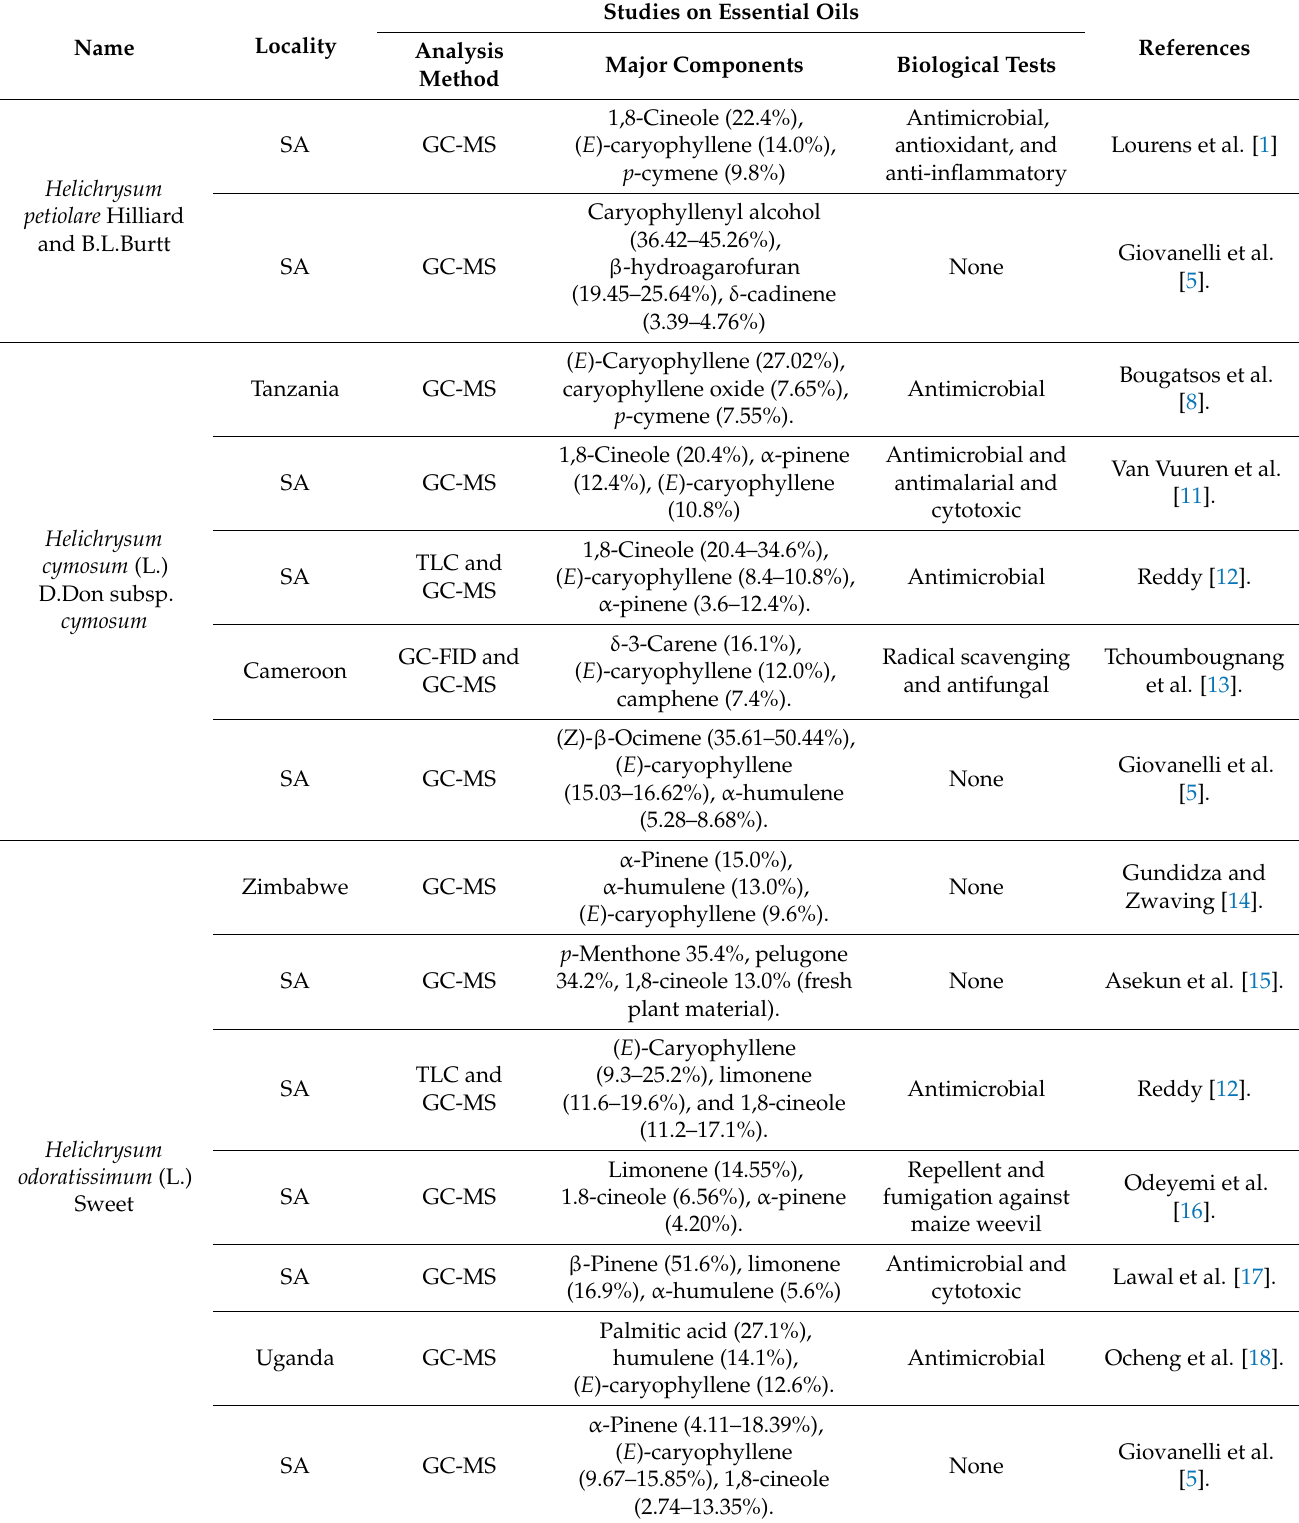
Table 1. Review of previous studies on essential oils of the selected Helichrysum species under